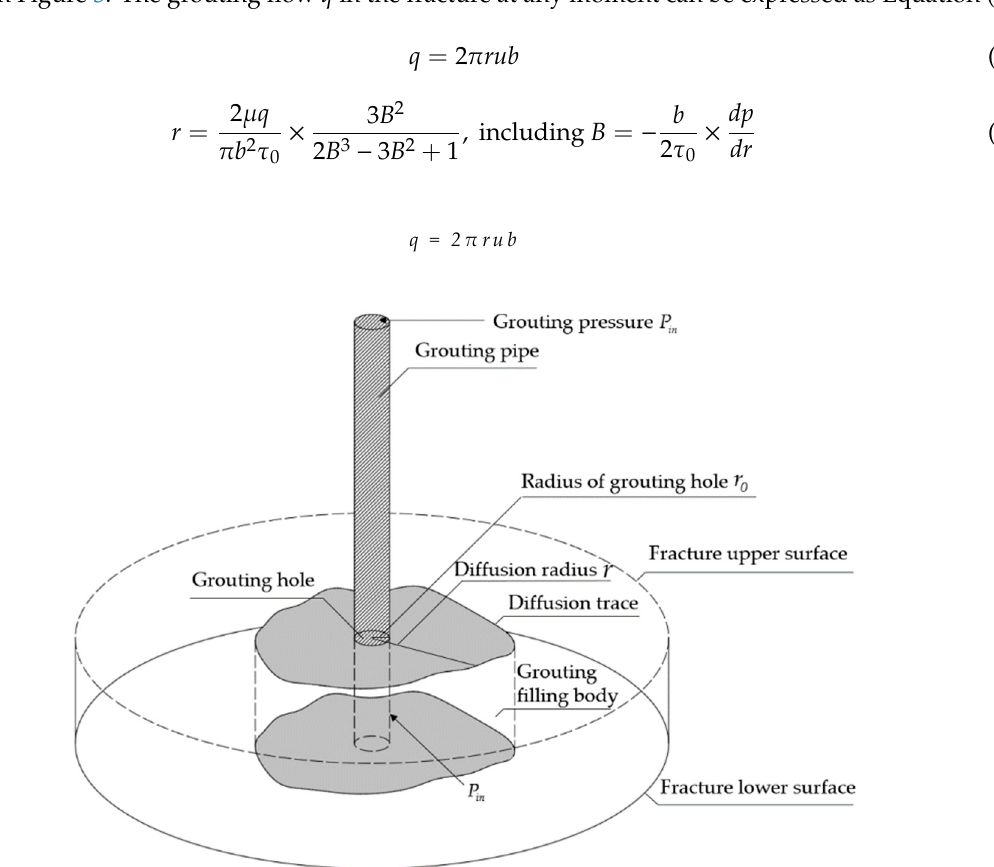
Figure 3. Calculation diagram of Bingham fluid diffusion in a three-dimensional parallel fracture.